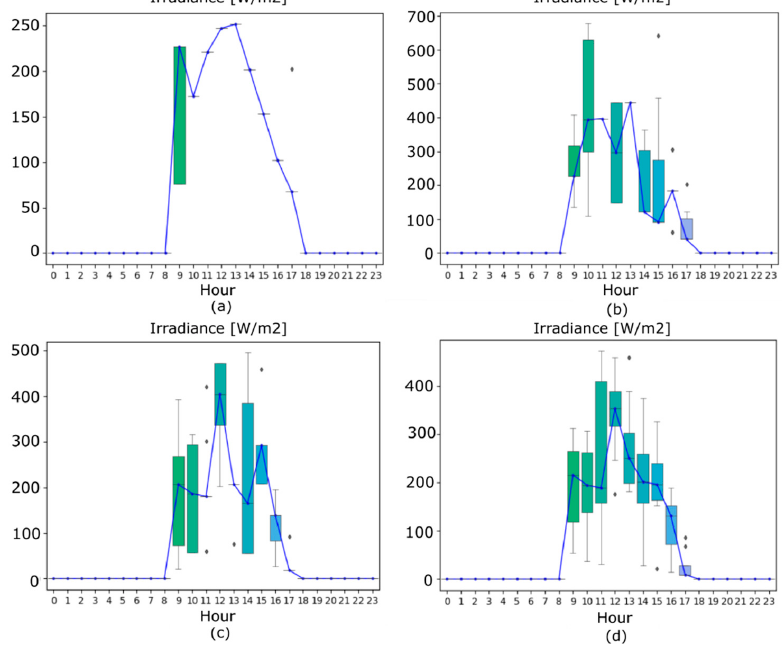
Figure 8. Median scenarios (blue) with box-whisker plot for scenarios generated for January using n S = 1000, n P = 10, and metric = (cid:96) 2 -Norm without outlier removal and varying the number of regions ( n R ): 3 ( a ), 5 ( b ), 11 ( c ), and 21 ( d